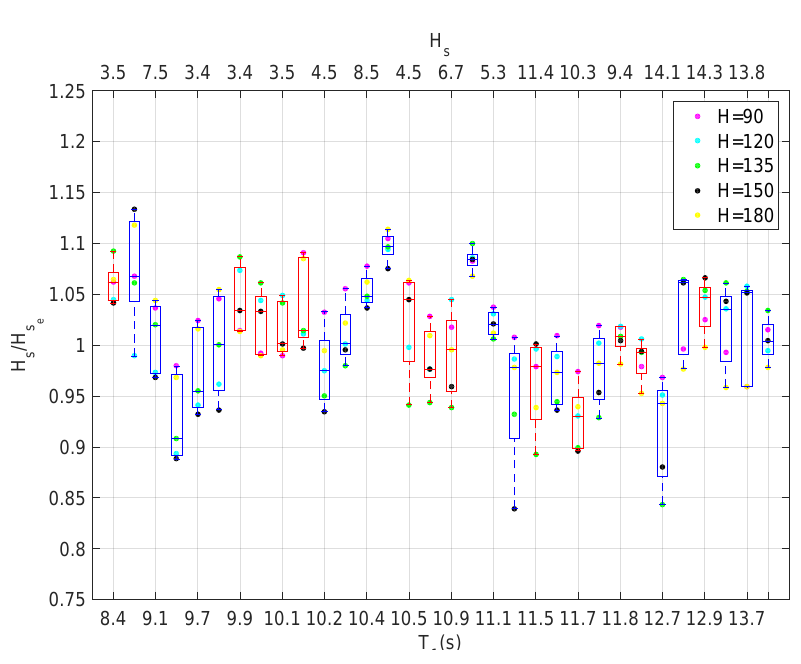
Figure 8. Box-plot showing the ratio between the estimated and measured significant wave height, obtained by means of the alternative prior distribution.